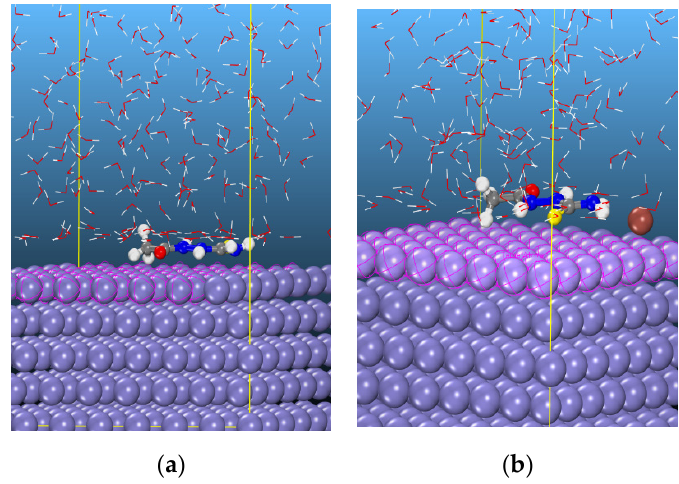
Figure 10. Snapshots of the most stable low energy configurations for the adsorption of ( a ) AST and ( b ) AST + I − on the Fe (110)/400 H 2 O interface obtained using the Monte Carlo simulation.